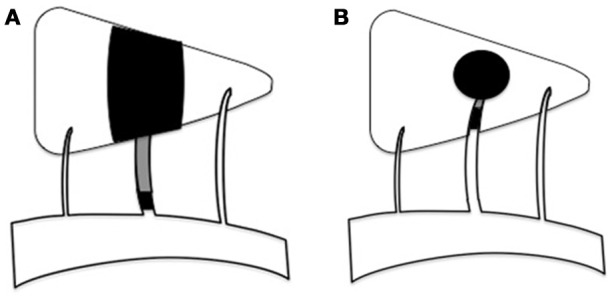
Schematic diagram of BAD and LI in anterior circulation. (A) BAD is considered to be caused by large artery atherosclerosis obstruction proximal branch or orifice of the penetrating artery. (B) LI is described as lipid hyalinization at the distal end of the perforating artery.